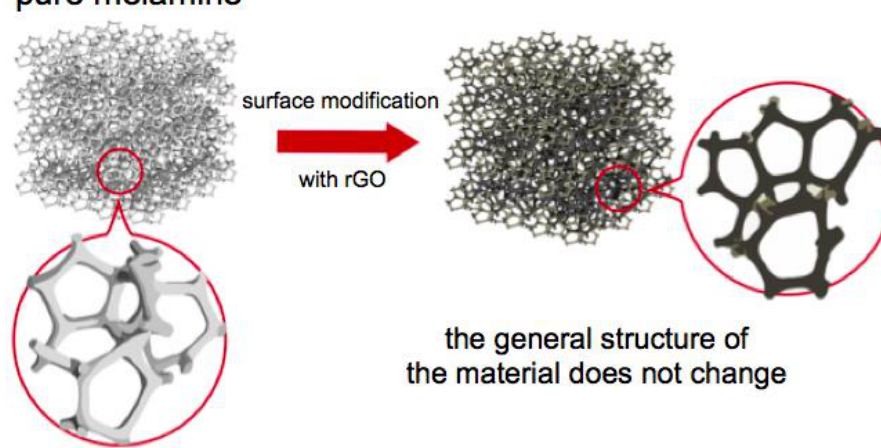
Figure 1. General scheme for obtaining sponge